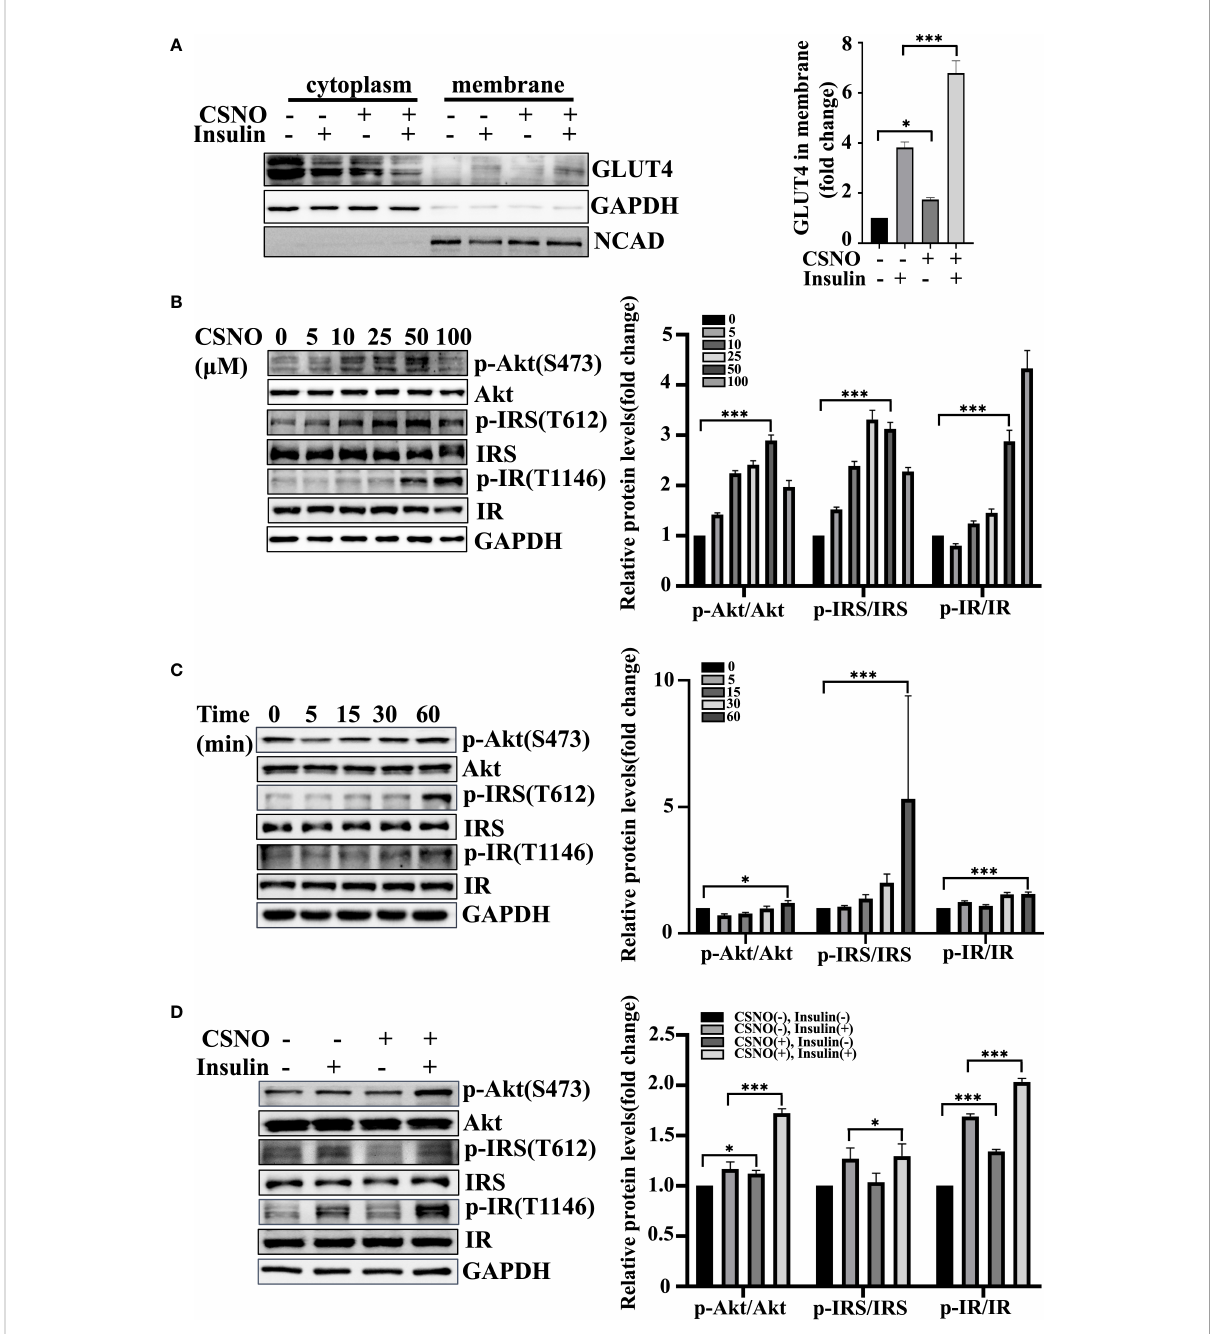
FIGURE 4 CSNO promoted GLUT4 membrane translocation and the insulin signaling pathway. (A) After the cytoplasm and cell membrane were separated, the expression of GLUT4 on membrane protein was detected. It was normalized to N-cadherin. (B) CSNO concentration-dependently activated the insulin signaling pathway in H9c2 cells. The expression level and phosphorylation level of Akt, IRS and IR were analyzed by Western blot. The protein band diagram and quantitative statistical diagram are shown. (C) CSNO time-dependently activated the insulin signaling pathway in H9c2 cells. The expression level and phosphorylation level of Akt, IRS and IR were analyzed by Western blot. The protein band diagram and quantitative statistical diagram are shown. (D) CSNO promoted activation of the insulin signaling pathway and further increased the effect of insulin on the insulin signaling pathway. The expression level and phosphorylation level of Akt, IRS and IR were analyzed by Western blot. The protein band diagram and quantitative statistical diagram are shown. * represents p < 0.05; *** represents p <